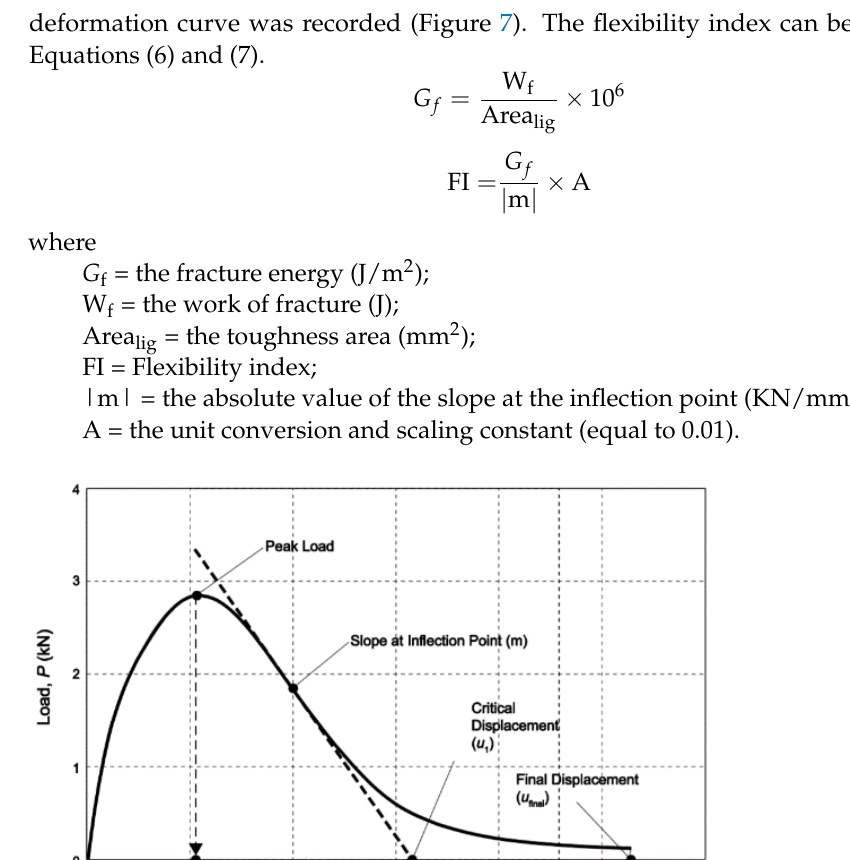
Figure 7. SCB test load-displacement curve.